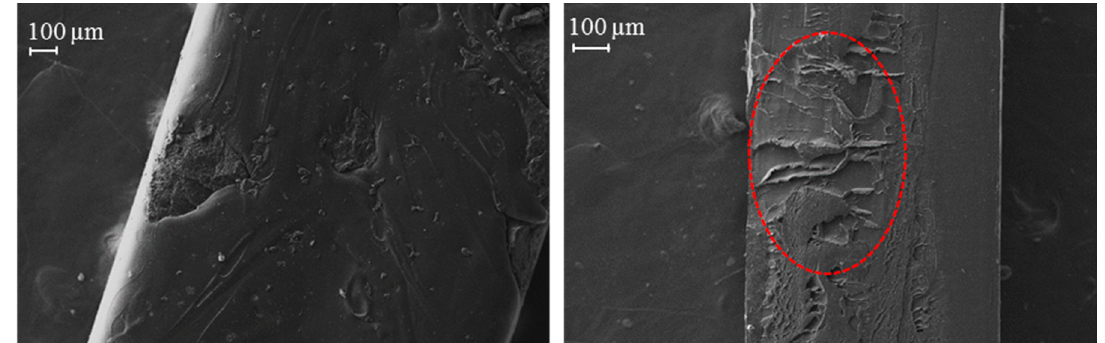
Figure 8. SEM micrographs of a PLA specimen loaded with 6 wt-% of TCS ( left ) and CHX ( right ) molded at 24-300-1.2 condition. molded at 24-300-1.2